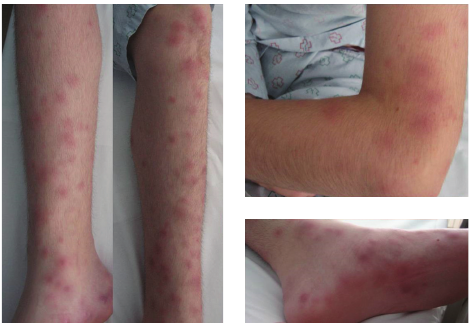
Figure 1: Erythematous nodules and plaques on the legs, arms, and soles.